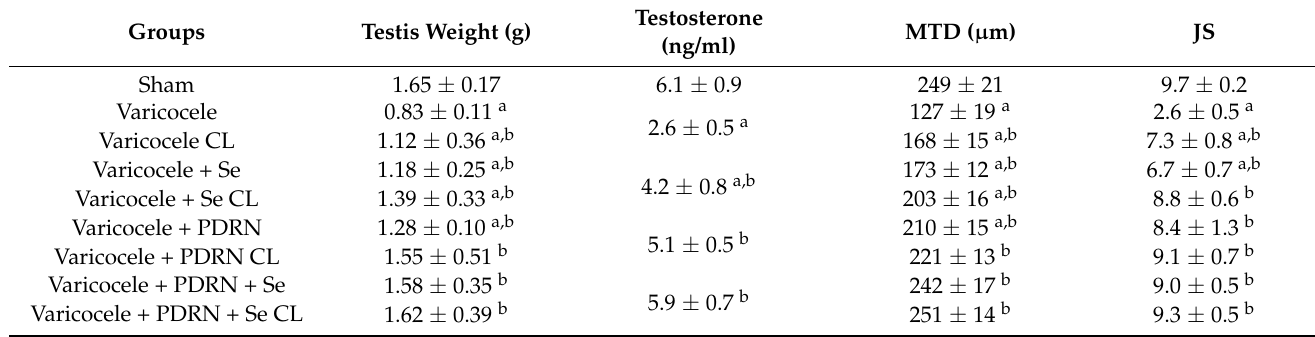
Table 1. Effects on testis weight, testosterone, mean tubular diameter (MTD) and Johnsen’s score (JS) induced by Se (0.4 mg/kg i.p.), PDRN (8 mg/Kg/day i.p.) and Se (0.4 mg/kg i.p.) plus PDRN (8 mg/Kg/ day i.p.) in varicocele rats as compared to sham and varicocele rats. Se = seleno-L-methionine; PDRN = polydeoxyribonucleotide; CL = contralateral testis. All values are expressed as mean ± SE; n = 7 animals for each group. a p < 0.05 vs. sham; b p < 0.05 vs. varicocele.